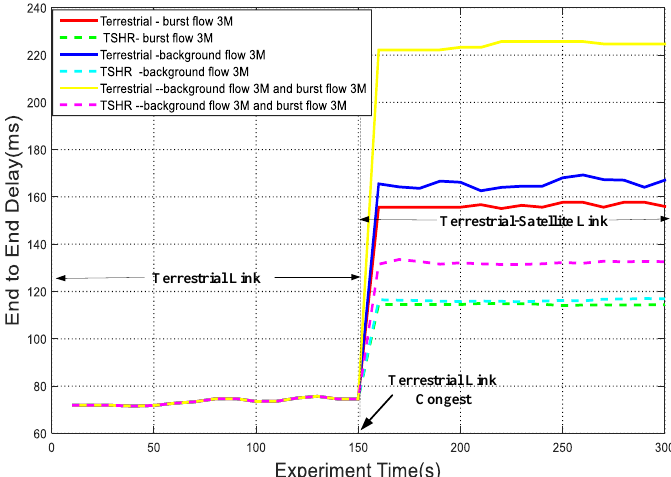
Figure 13. End-to-end delay in congestion